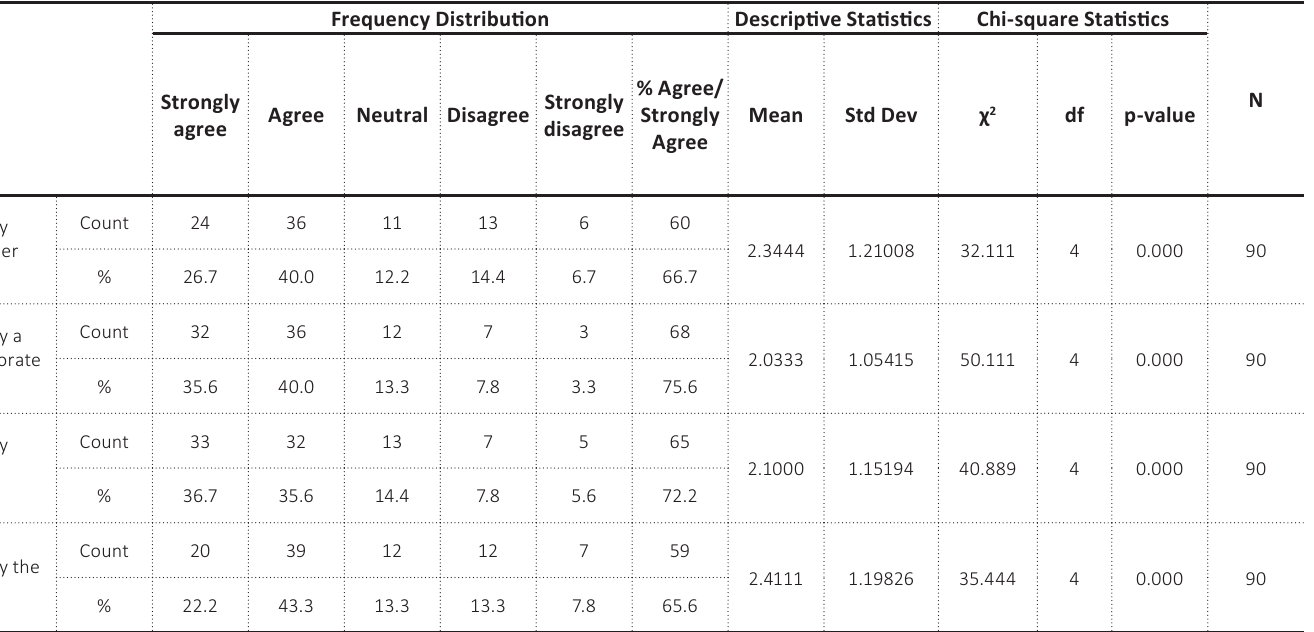
Table 3. Frequency distribution, descriptive statistics, and chi-square statistics of the networking challenges Frequency Statement